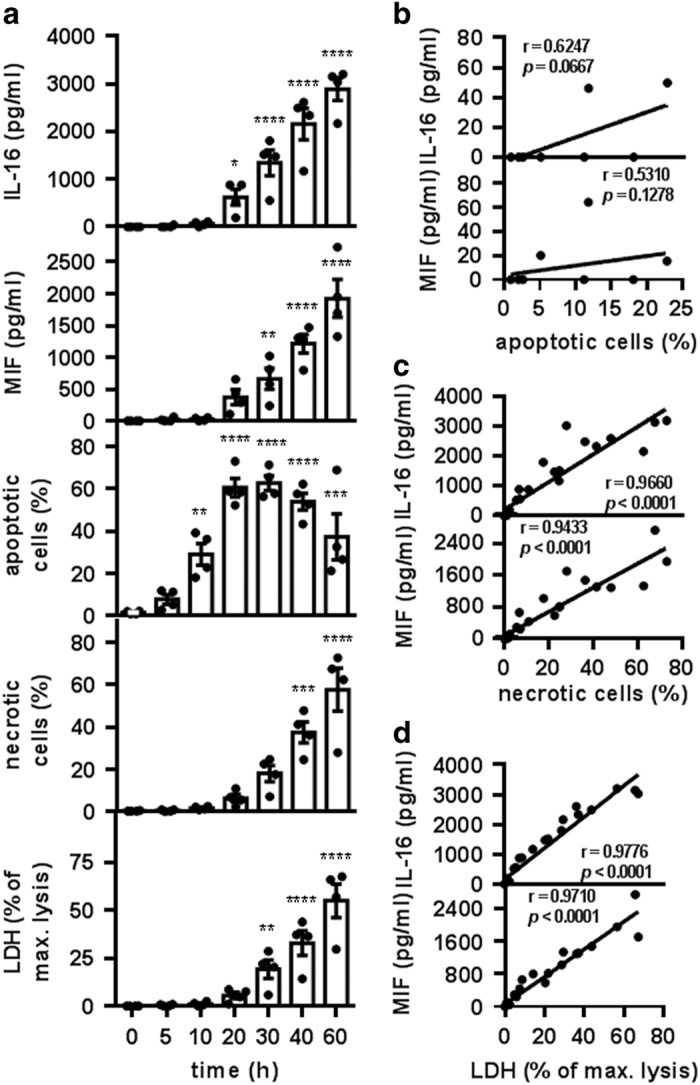
IL-16C release during secondary necrosis of neutrophils. (a–d) Neutrophils were incubated for 0, 5, 10, 20, 30, 40 and 60 h at 37 °C. (a) At the indicated time points, the samples were centrifuged at 400×g for 10 min. Supernatants were collected and centrifuged at 4 °C and 60 000×g for 1 h before being analyzed with ELISA for released IL-16 and MIF and with a cytotoxicity detection kit for LDH (depicted in % of max. lysis, as obtained by lysis of freshly isolated neutrophils with Triton X-100). Neutrophil viability was assessed with flow cytometry using Annexin-V-FLUOS and PI staining. Bars represent the means±S.E.M. of four independent experiments (*P<0.05; **P<0.01; ***P<0.001, ****P<0.0001 compared with the 0-h sample by one-way ANOVA followed by Holm Sidak multiple comparisons correction). Individual data points are shown as black dots. (b–d) Correlation analysis of the data obtained in a, analyzed by nonparametric Spearman correlation, P (two-tailed). (b) The correlation between the percentage of apoptotic neutrophils and the concentration of IL-16 (top) or MIF (bottom) in the supernatants. Samples containing more than 3% necrotic cells were excluded. n=10. (c) The correlation between the percentage of necrotic neutrophils and the concentration of IL-16 (top) or MIF (bottom) in the supernatants. n=28. (d) The correlation between the percentage of LDH release and the concentration of IL-16 (top) or MIF (bottom) in the neutrophil supernatants. n=28.